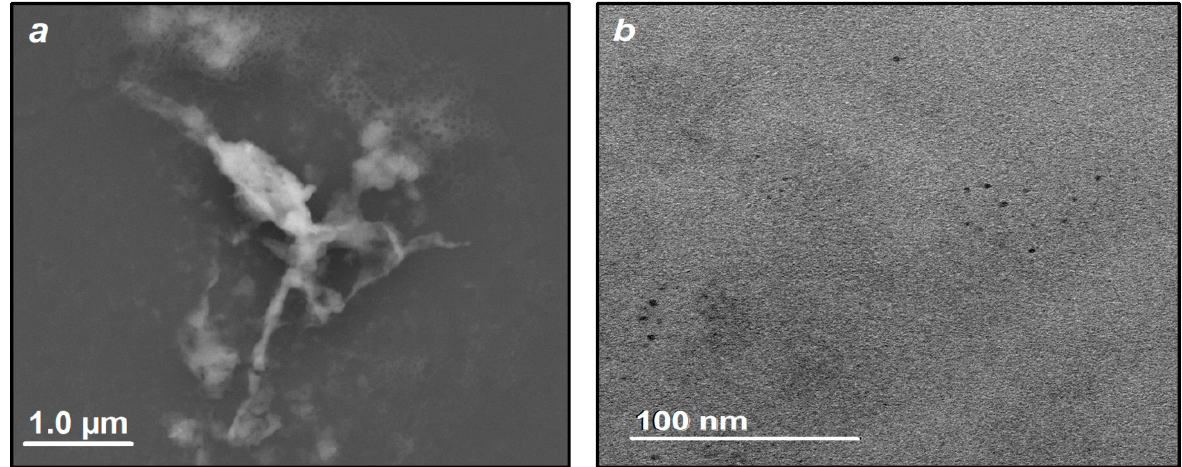
Figure 8. ( a ) SEM image of the CuI-PPy composite (sample 4) formed by the use of the ink stored for 6 weeks; ( b ) TEM image of the rinsed ink after its storage in darkness in aqueous solution at the ambient conditions during 6 weeks.